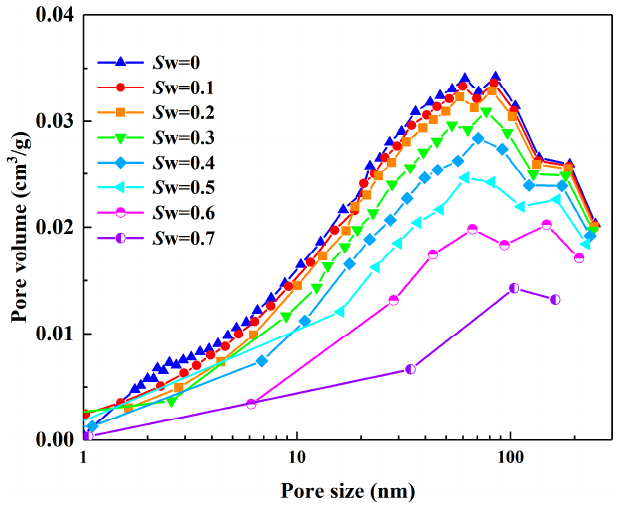
Figure 16. Effective PSD in inorganic matrix varies with water saturation.